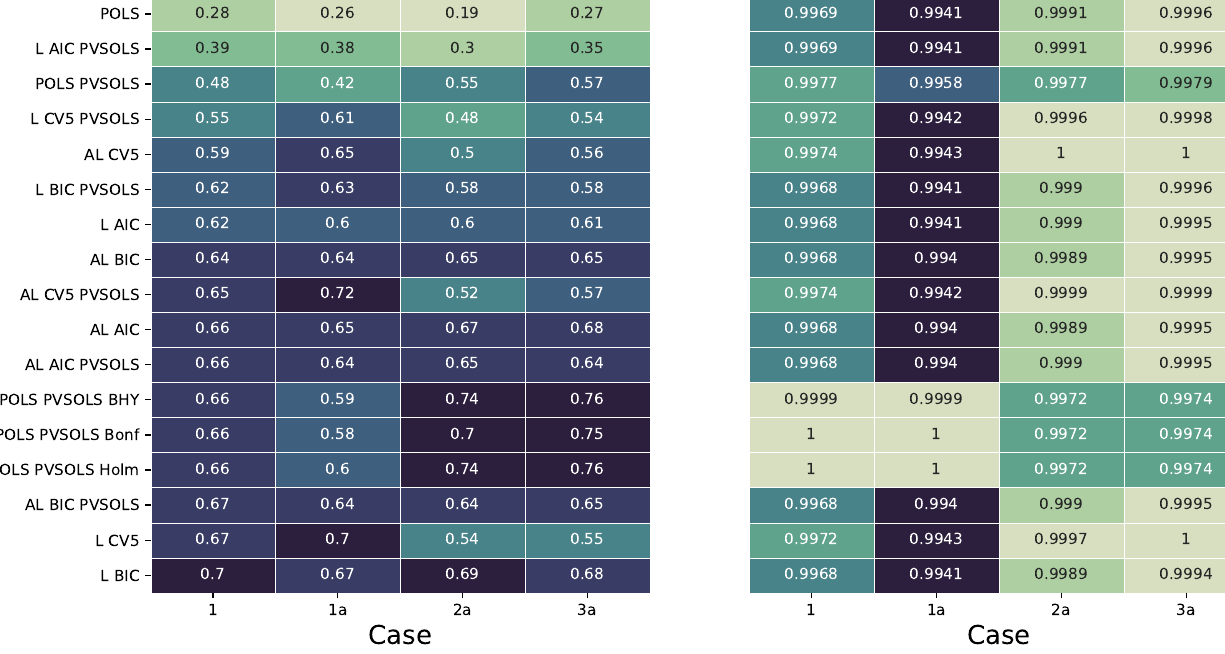
Figure A1. The figure shows the simulated out-of-sample prediction evaluation for each method. Pooled OLS (POLS), Lasso AIC with post-variable selection OLS (L AIC PVOLS), pooled OLS with post-variable selection OLS (POLS PVOLS), Lasso CV5 with post-variable selection OLS (L CV5 PVOLS), adaptive Lasso CV5 (AL CV5), Lasso BIC with post-variable selection OLS (L BIC PVOLS), Lasso AIC (L AIC), adaptive Lasso BIC (AL BIC), adaptive Lasso CV5 with post-variable selection OLS (AL CV5 PVOLS), adaptive Lasso AIC (AL AIC), adaptive Lasso AIC with post-variable selection OLS (AL AIC PVOLS), pooled OLS with post-variable selection OLS and the BHY t-value adjustment(POLS PVOLS BHY), pooled OLS with post-variable selection OLS and the Bonferroni t-value adjustment (POLS PVOLS Bonf), pooled OLS with post-variable selection OLS and the Holm t-value adjustment(POLS PVOLS Holm), adaptive Lasso BIC with post-variable selection OLS (AL BIC PVOLS), Lasso CV5 (L CV5) and Lasso BIC (L BIC). The plot on the left side shows average MCS p-values over 200 simulation cases, where the p-value measures if the model is part of the MCS. The right figure illustrates the MSE values relative to the max of each case. Please note that the results displayed are based on 200 simulations